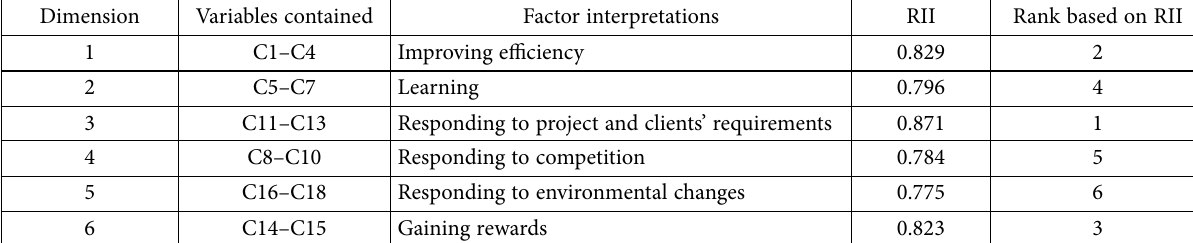
Table 7. Factor analysis of drivers of collaborative